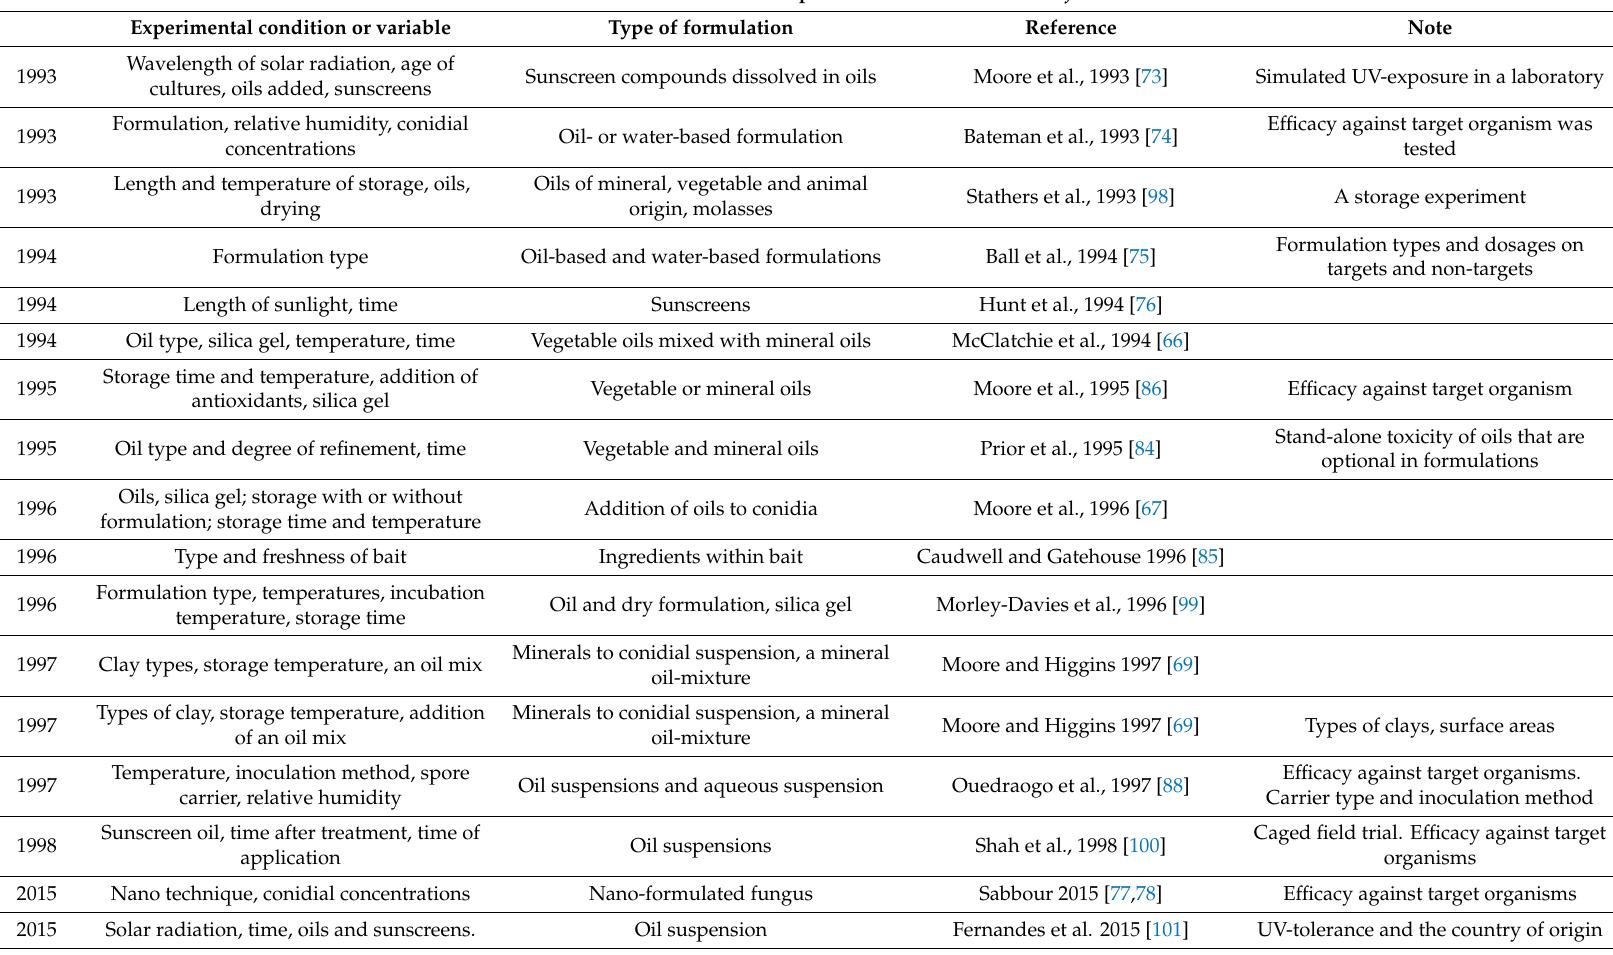
E ff ect of formulation on the performance of Metarhizium